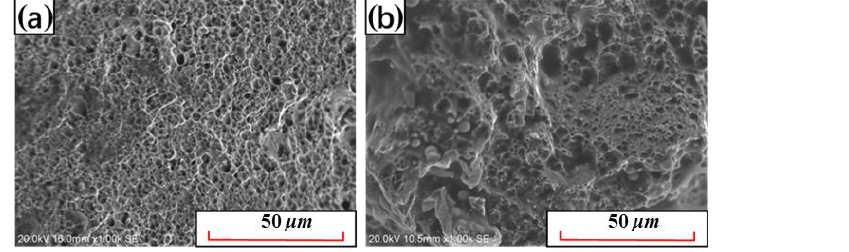
Table 2. Comparison of mechanical properties between 22MnB5NbV and 22MnB5 steel.